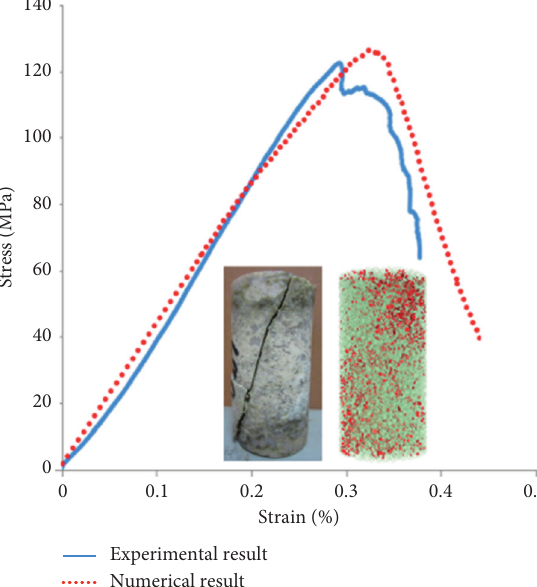
Figure 10: Comparison of uniaxial compressive test from experimental and numerical results. Table 8: Comparison of mechanical parameters between experimental and numerical tests. Mechanical property